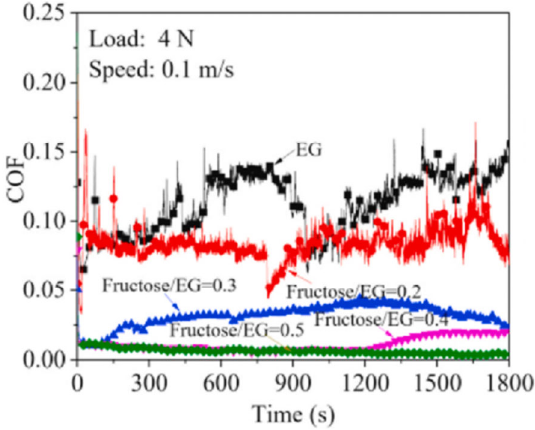
Fig. 8 Friction behavior of pure EG and fructose/EG solutions [110]. Reproduced with permission from Ref. [110], © Elsevier B.V., 2021.